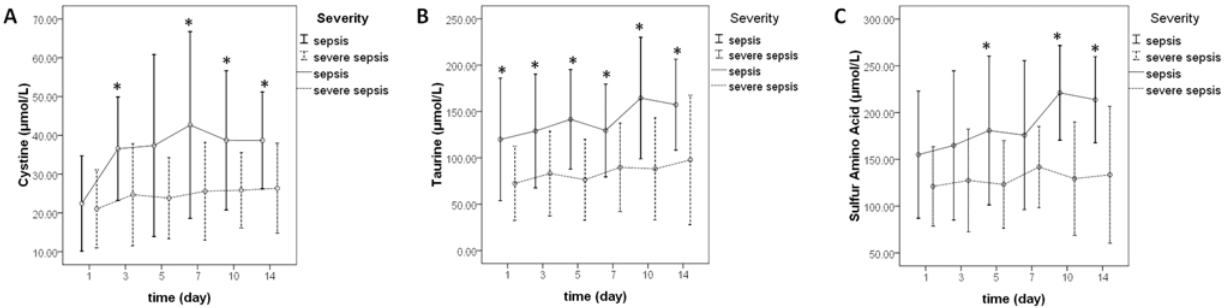
Fig 2. The dynamic changes in cystine (A), taurine (B), and sulfur-containing amino acid (C) levels between the sepsis and severe sepsis groups on days 1, 3, 5, 7, 10, and 14. * P <